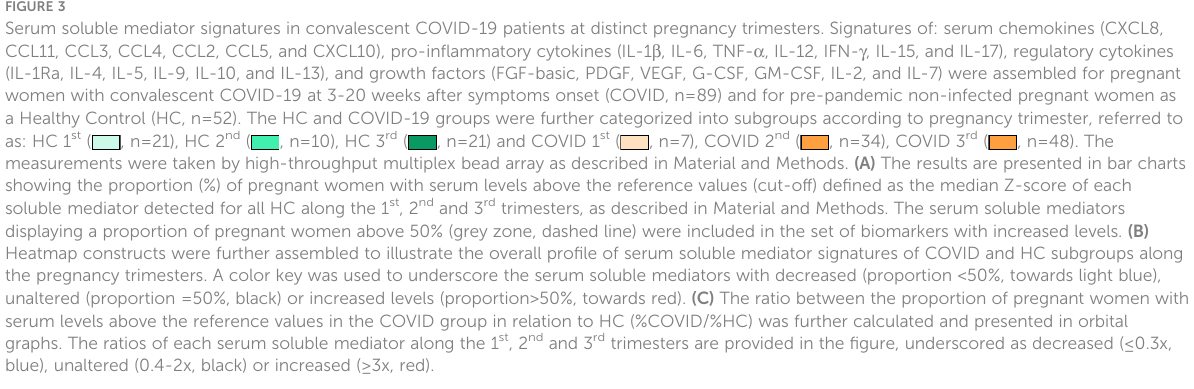
Data analysis demonstrated that the number of preserved attributes referred to as common in HC and COVID ( ≥ 5 strong